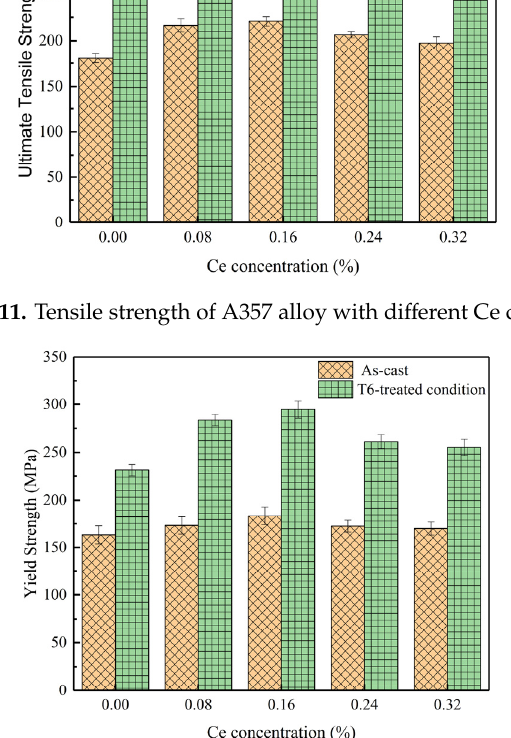
Figure 12. Yield strength of A357 alloy with different Ce content.